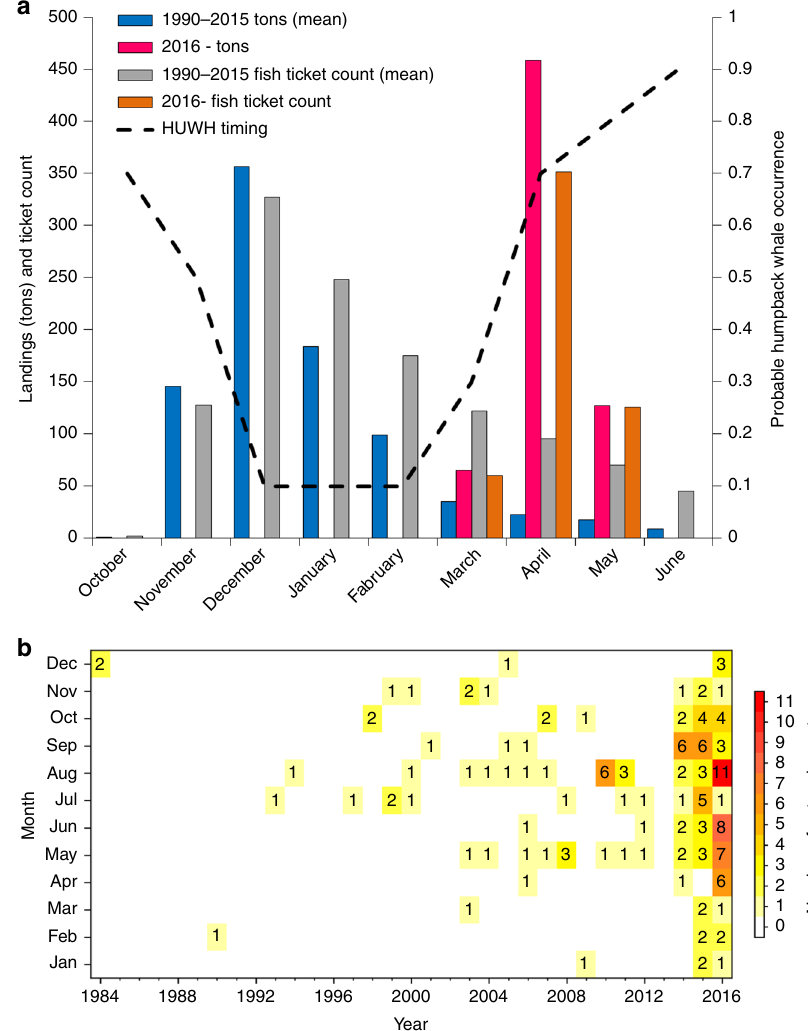
Fig. 4 California Dungeness Crab fi shery and humpback whale entanglements. a Summary of landings data by month for the California Dungeness Crab fi shery; shown here as the long-term mean of 1990 – 2015 and the unusual delayed fi shing season for 2016. Dashed line illustrates the assumed relative probability of occurrence for humpback whales (HUWH) off California re fl ecting their seasonal migration (derived from expert opinion, past surveys, and whale-watching activity). b Time series and summary of monthly con fi rmed humpback whale entanglements throughout the California Current illustrates the expansion of entanglements throughout the marine heatwave period (2014 – 2016). Source data are provided as a Source Data fi